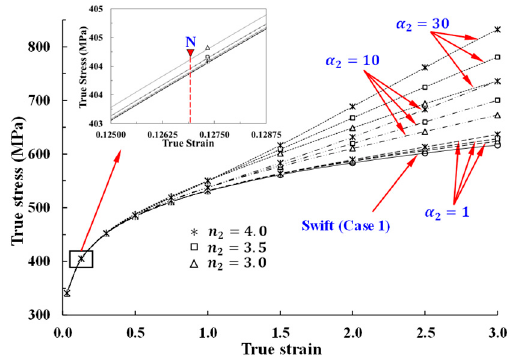
Figure 4. Effect of 𝑛 (cid:2870) on the flow curve.